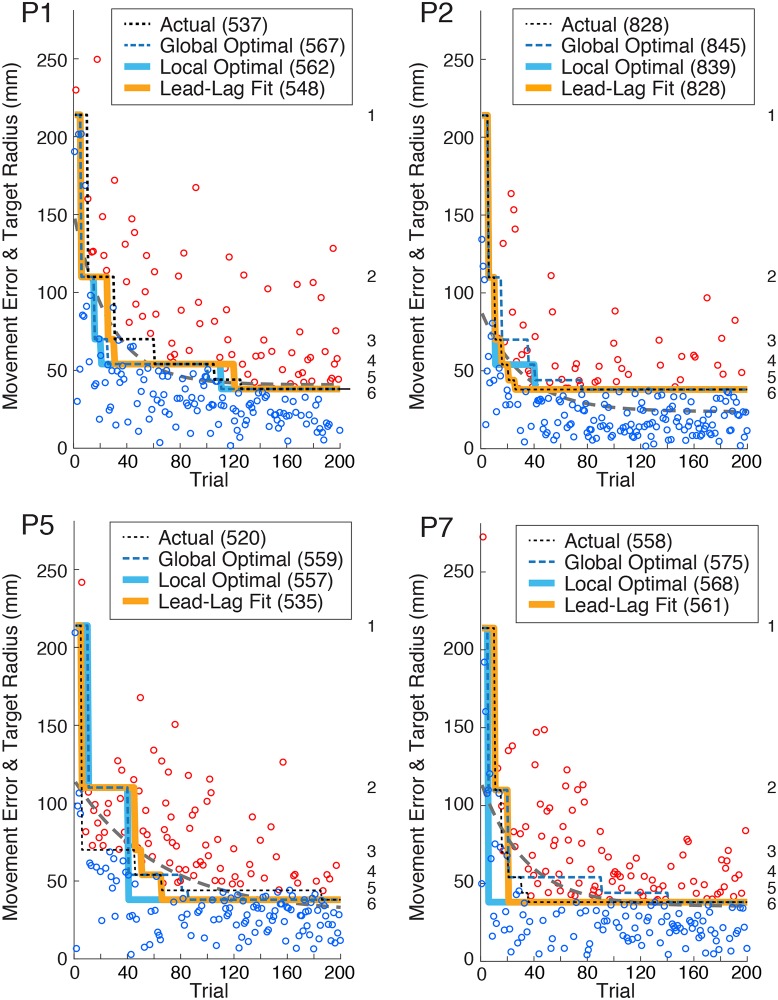
Movement errors (circles) and actual target selections (dotted black lines) as a function of trial for four representative participants.Target numbers are shown on the right of each panel. For each participant, target selections made by three models are shown: global optimal, local optimal, and lead-lag. Points earned by the participant and by the three models are shown in parentheses at the top in each panel. Movement error is color-coded by success (blue = hit, red = miss). Dashed gray line indicates fit of movement error to an exponential function of the form aebx
+ c.